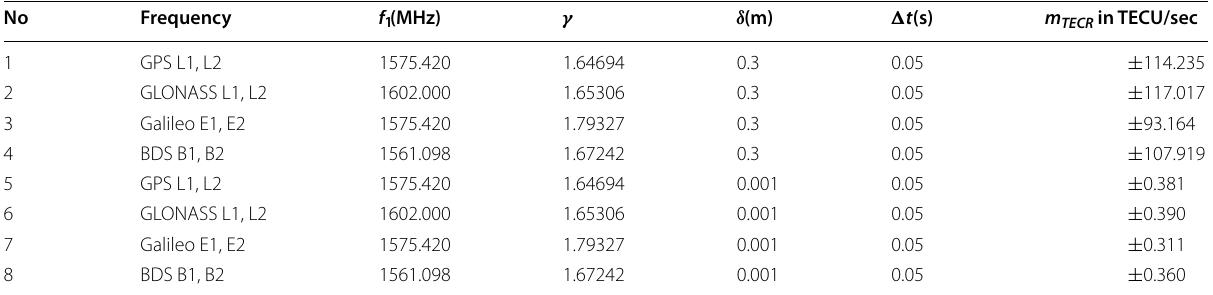
TECU/sec represents total electron content unit (TECU) per second